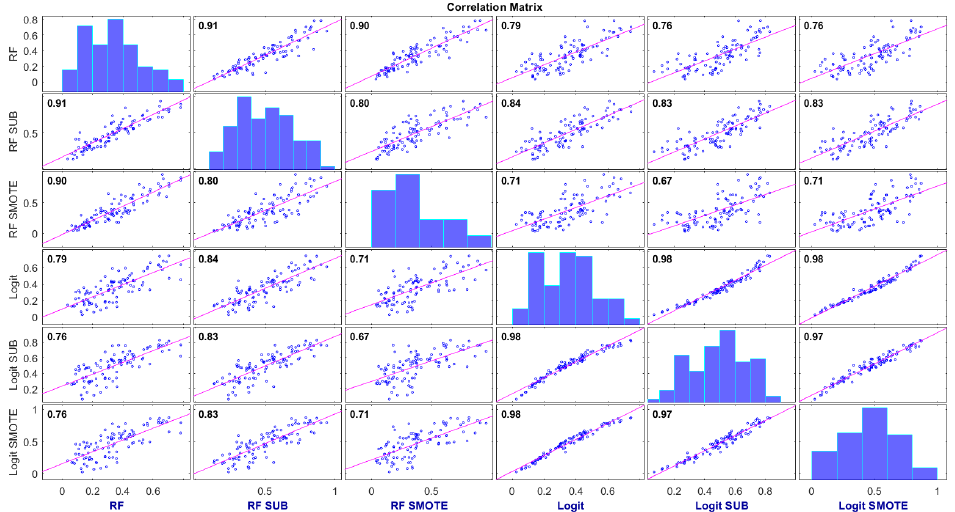
Figure 5. Correlation between the probability scores of the samples in the hold-out test set resulting from each classification